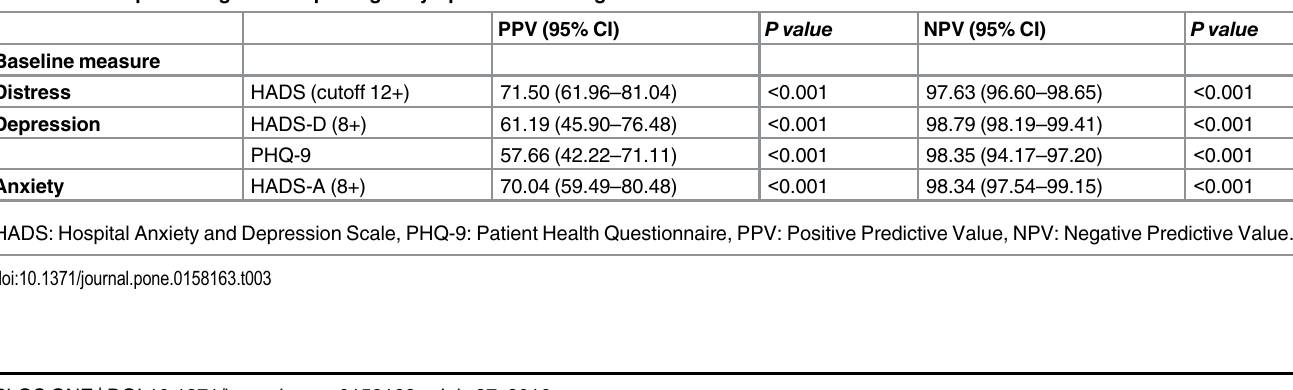
Table 3. Model predicting future reporting of symptoms according to baseline